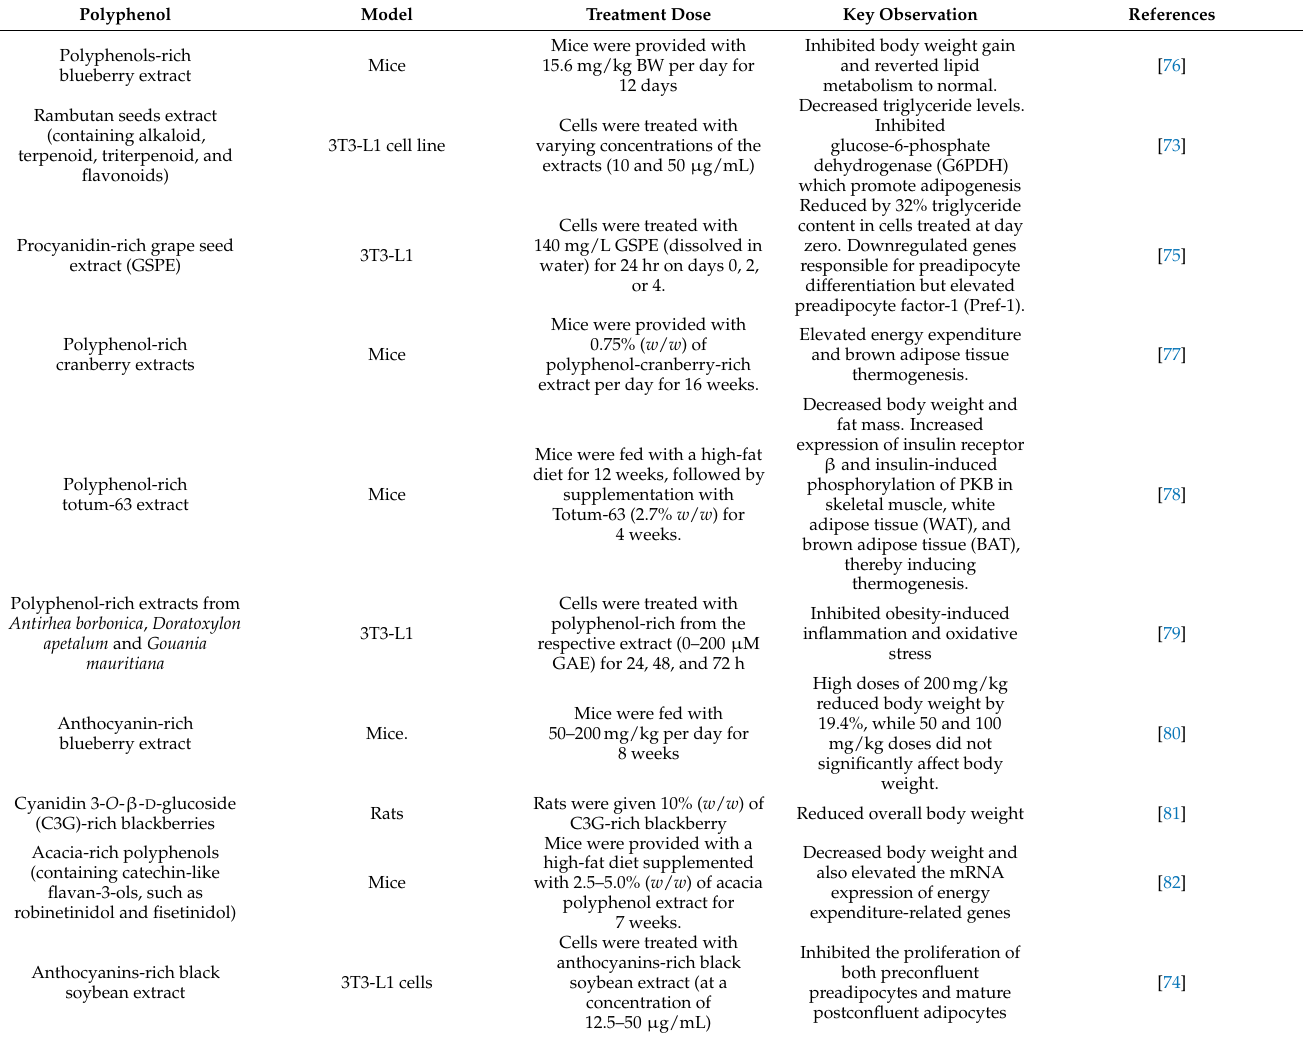
Table 3. Cellular and animal studies on the potential effects of polyphenols and polyphenol-rich extracts on